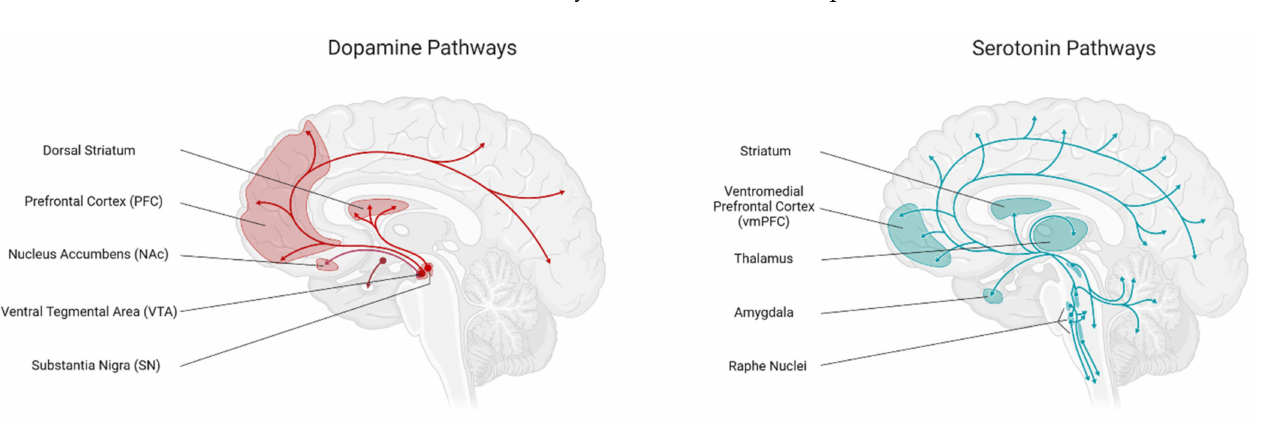
Figure 3. Central serotonin and dopamine pathways in food intake